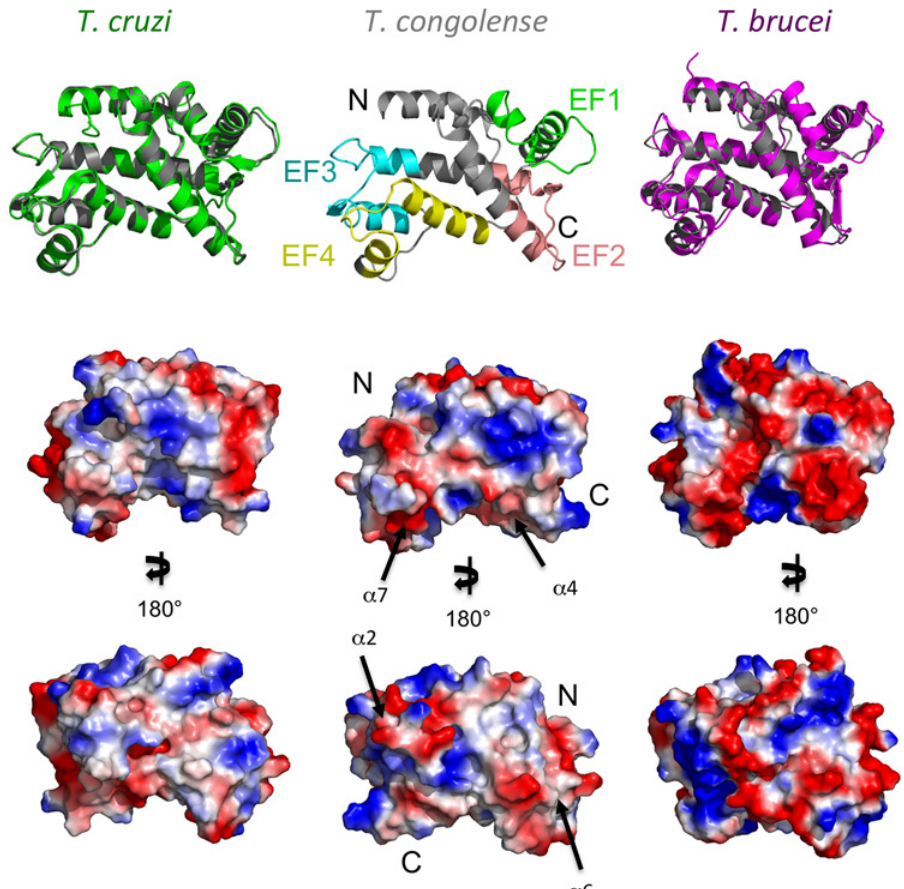
Fig 6. Structural characterization and surface analysis of T . congolense calflagin Modeled T . congolense calflagin (middle panel) was compared to the crystal structure of T . cruzi FCaBP (left vertical column) and to the NMR structure of T . brucei Tb24 (right vertical column). (A) the predicted model of T . congolense calflagin (middle vertical column) exhibits four EF-hands motifs. The EF-hands (EF1, EF2, EF3 and EF4) are colored green, salmon, cyan, yellow, accordingly. Left panel: structural alignment of T . congolense (grey) over T . cruzi FCaBP (green). Right panel: T . congolense calflagin structure aligned over T . brucei Tb24 (magenta). (B) Surface representation of the three calflagin models overlapping panel A, showing exposed hydrophobic (gray), basic (blue) and acidic (red) respectively. (C) 180° rotation of B in the y-axis . Black arrows pointing towards putative epitopes and numbered according to their respective α -helix location.